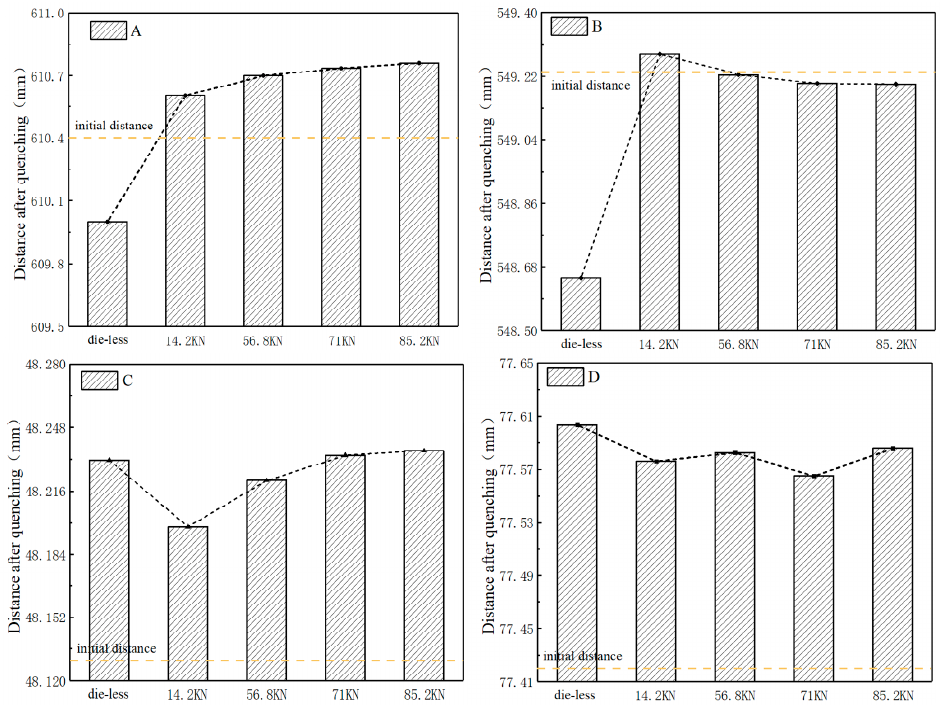
Figure 16. Deformation of gears in key positions (as shown in Figure 13A–D) under different loads.